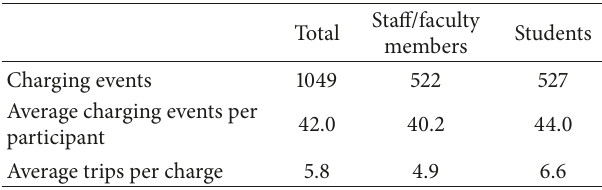
Table 3: Battery charging